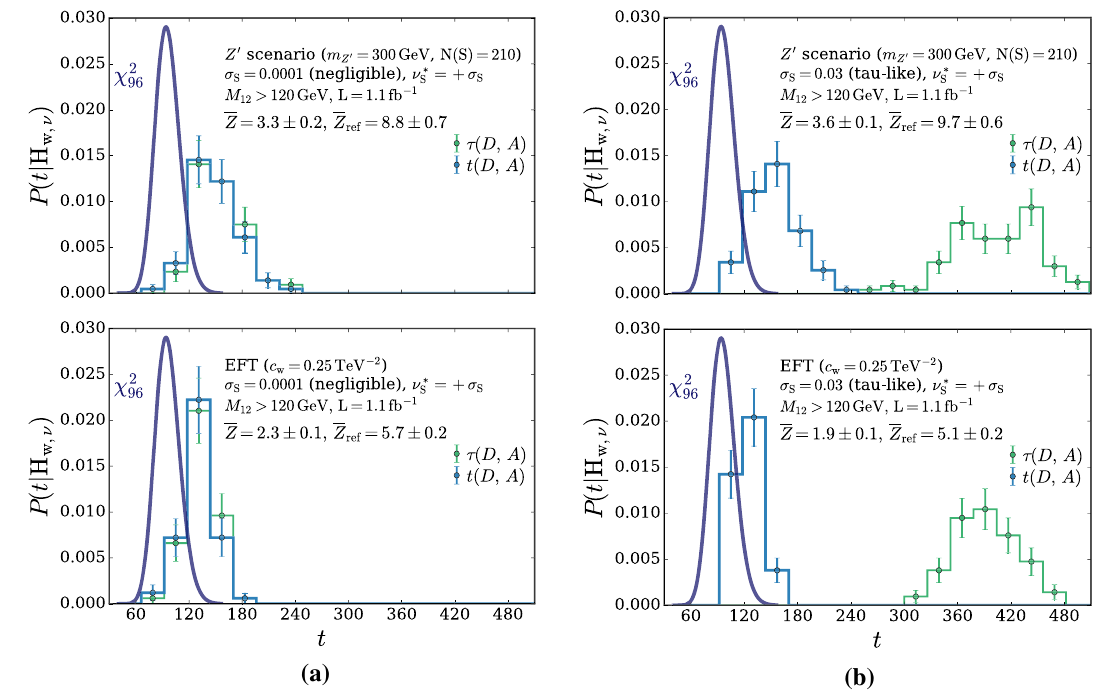
Fig. 24 Sensitivity to two New Physics scenarios in the case of neg- ligible uncertainties ( a ) and τ -like regime ( b ). The upper panels show the sensitivity of the method to the presence of a Z (cid:16) ( m Z (cid:16) = 300 GeV, N ( S ) = 210) resonance in the two leptons invariant mass. The lower